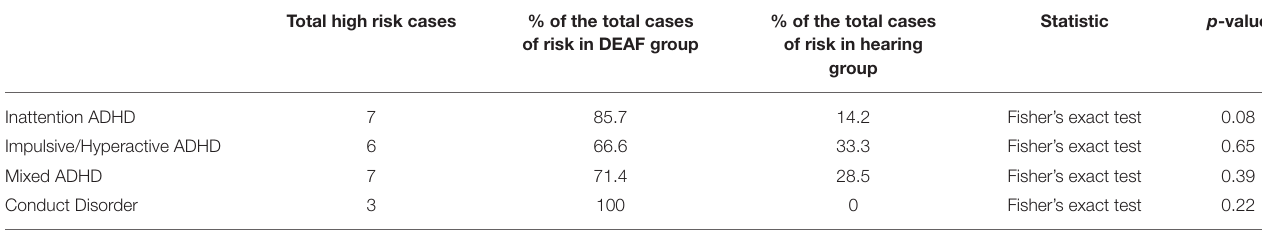
TABLE 1 | Cases with risk of ADHD and CD detected by EDAH.